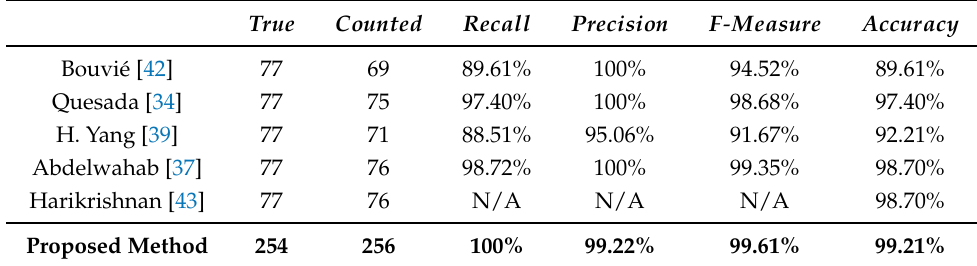
Table 17. Comparison results of the benchmark M-30.